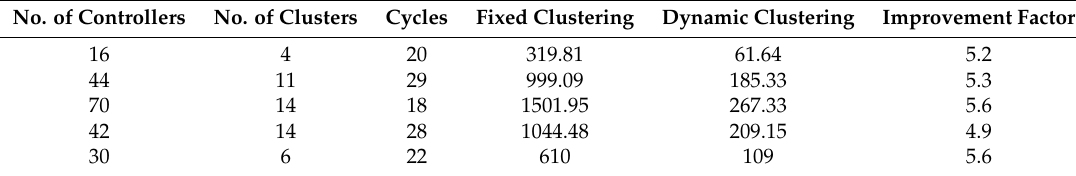
Table 4. Dynamic vs. Fixed Clustering in different network